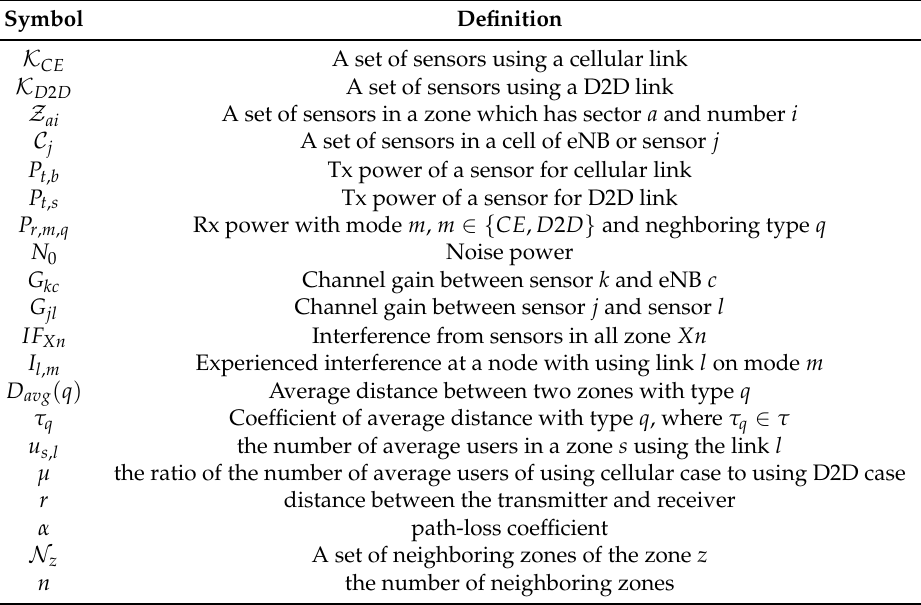
Table 1. Definition of